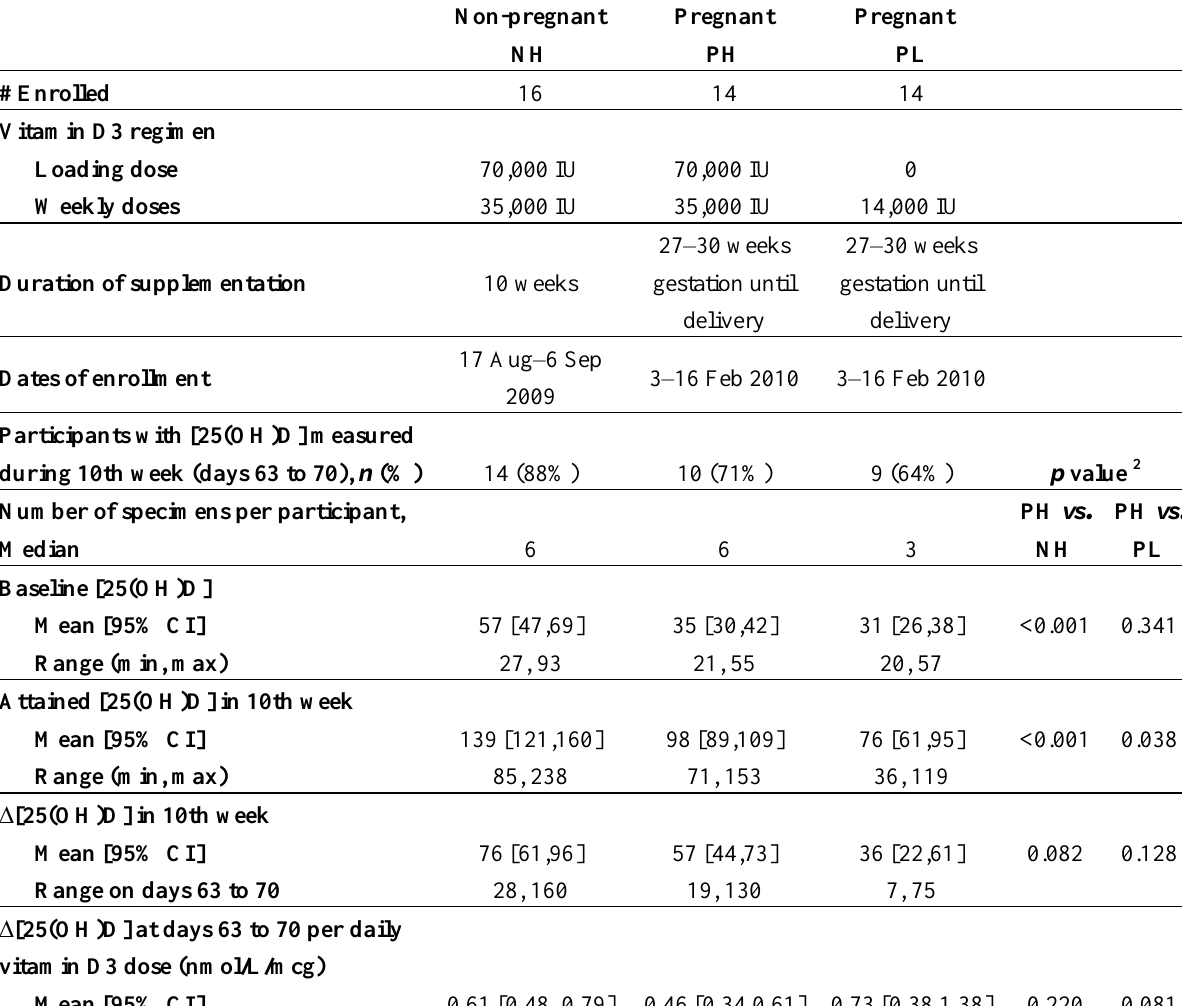
Table 2. Serum 25-hydroxyvitamin D concentrations at baseline and through 10 weeks of supplementation in non-pregnant and pregnant participants 1